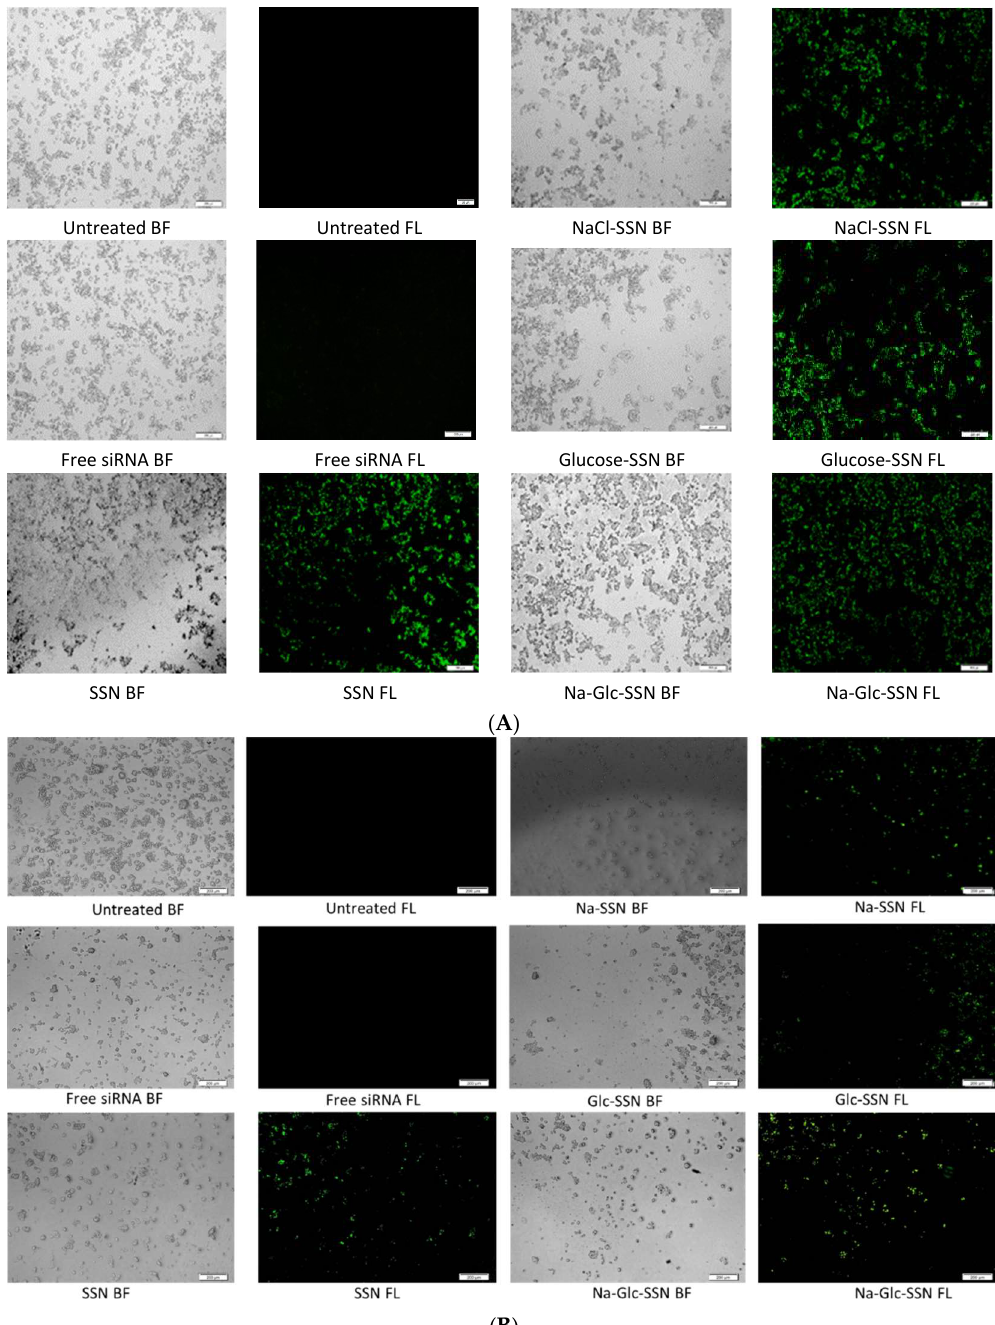
Figure 11. Cellular uptake of strontium sulfite particles with bound fluorescence-labeled siRNA. MCF-7 cells were treated with media (untreated), free siRNA and different strontium sulfite particles. SSNs, NaCl-SSNs, Glc-SSNs and Na-Glc-SSNs with loaded siRNA were formed by adding SrCl 2 (60 mM), Na 2 SO 3 (10 mM) and 10 nM of AF488 negative siRNA in presence or absence of NaCl (300 mM) and/or glucose (200 mM) at ( A ) 4 h of treatment and ( B ) 12 h of treatment.